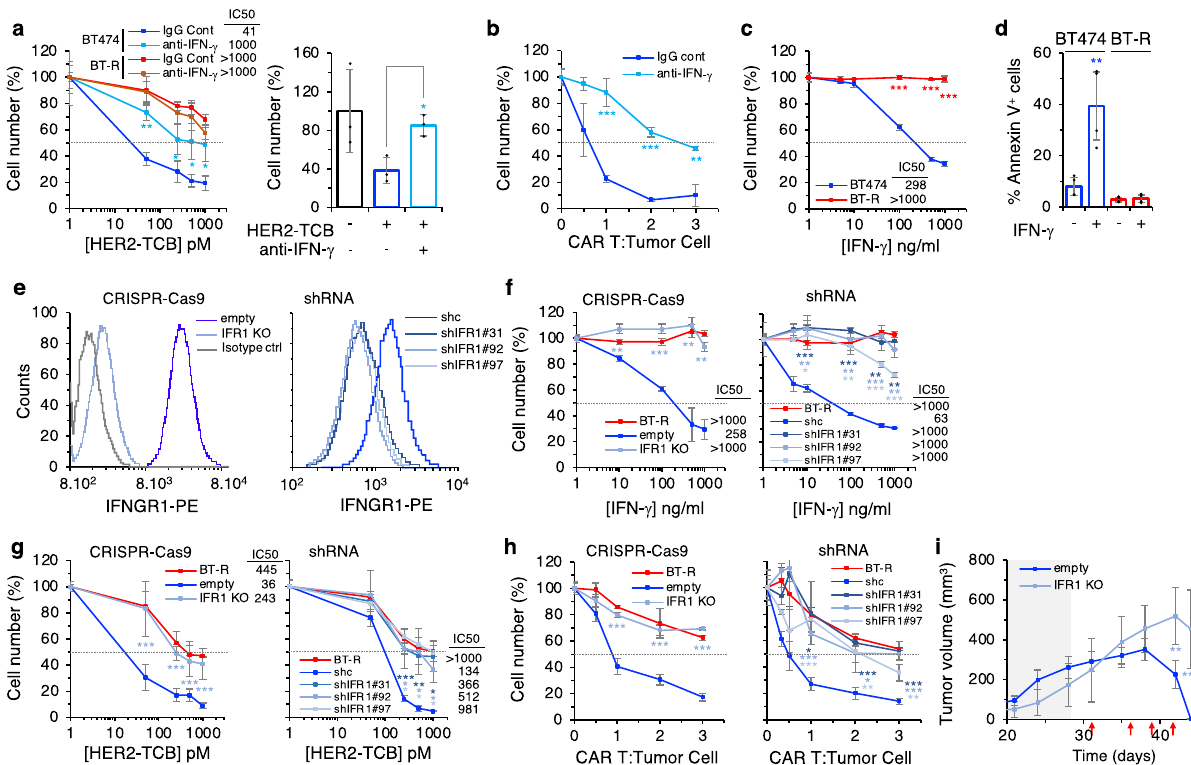
Fig. 3 IFN- γ response is required for ef fi cient killing by redirected lymphocytes. a Left, cocultures of PBMCs with BT474 or BT-R cells were treated with different concentrations of HER2-TCB in presence of an IgG control or an IFN- γ blocking antibody for 72h. Then, viable cells were quanti fi ed by fl ow cytometry using EpCAM as a marker. Right, BT474 cells were grown in 3D and treated with HER2-TCB in presence of an IgG control ( − ) or an IFN- γ blocking antibody ( + ) for 72h. Viable BT474 cells were quanti fi ed by fl ow cytometry using EpCAM as a marker. Results were normalized to untreated cells. b Parental BT474 cells were cocultured with different ratios of CAR T cells for 48h in the presence of an IgG control or an IFN- γ blocking antibody. Then, cell numbers were calculated and expressed as in ( a ). c Parental BT474 or resistant BT-R cells were treated with different concentrations of IFN- γ for 5 days. Cell numbers were estimated with the crystal violet staining assay. d Parental BT474 or resistant BT-R cells were treated with 1 μ g/ml of IFN- γ and the percentages of apoptotic cells were determined by means of Annexin V + cells measured by fl ow cytometry. e Cells were stained with anti-IFNGR1 or isotype antibody and analyzed by fl ow cytometry. IFR1 stands for IFNGR1. f Sensitivity of the indicated cells to IFN- γ was analyzed as in ( c ). g The indicated cells were treated with different concentrations of HER2-TCB and analyzed as in ( a ). h The indicated cell lines were cocultured with CAR Ts and analyzed as in ( b ). i Totally, 6.5×10 7 BT474 cells or the same cells knock-out for IFNGR1 were injected orthotopically into NSG mice. Mice were treated as described in Fig. 1c. Tumor volumes are represented as averages±SD (empty, n = 8; IFR1 KO, n = 4). a Left, ** p = 0.001, * p = 0.05; right, * p = 0.01. b *** p <0.001, ** p = 0.002. c *** p